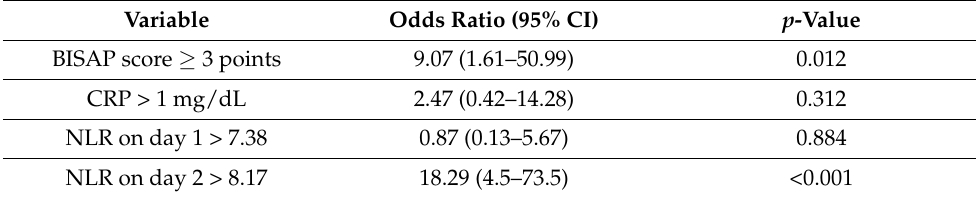
Table 4. Multiple logistic regression of severe post-ERCP